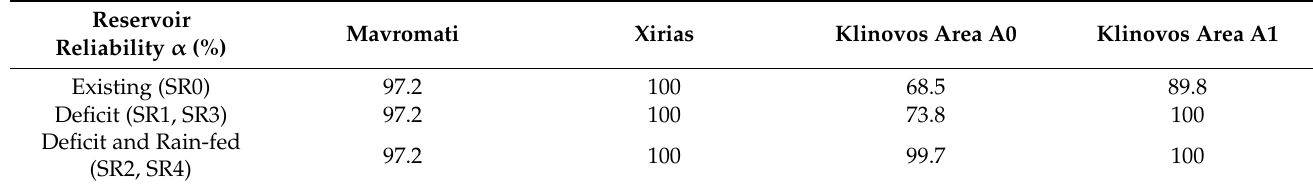
Table 7. Mean monthly reservoir reliability to satisfy water